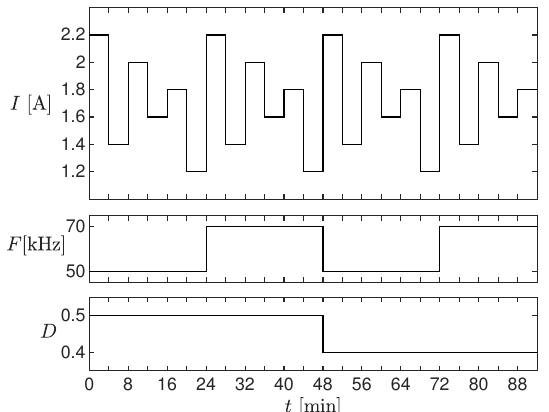
Figure 11. Operating conditions used for testing the estimator.